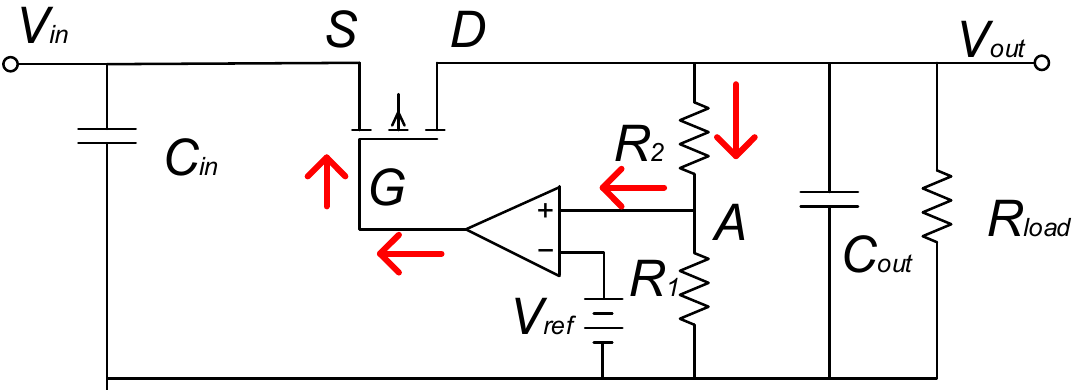
Figure 8. Principle of the fourth-stage converter LDO.